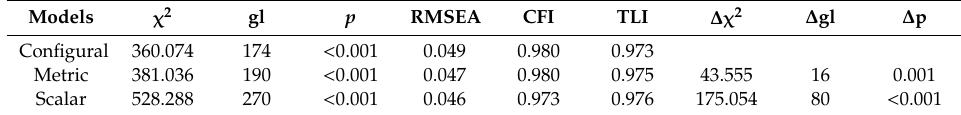
Table 3. Goodness of fit indices of nested model of factor invariance analysis according to sex.